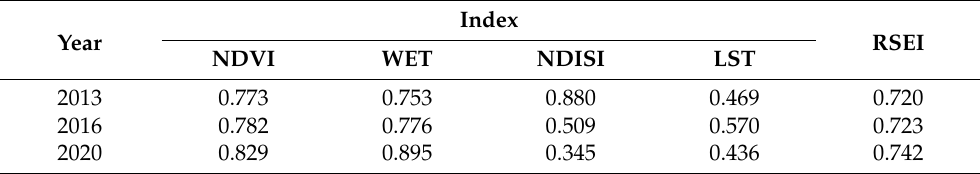
Table 2. RSEI and mean value of each index.